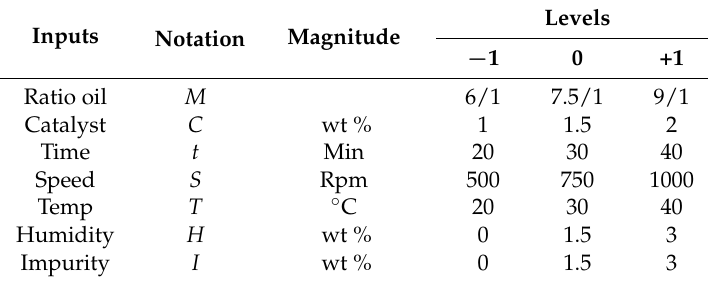
Table 1. Factors and levels applicable to the Box–Behnken DoE.